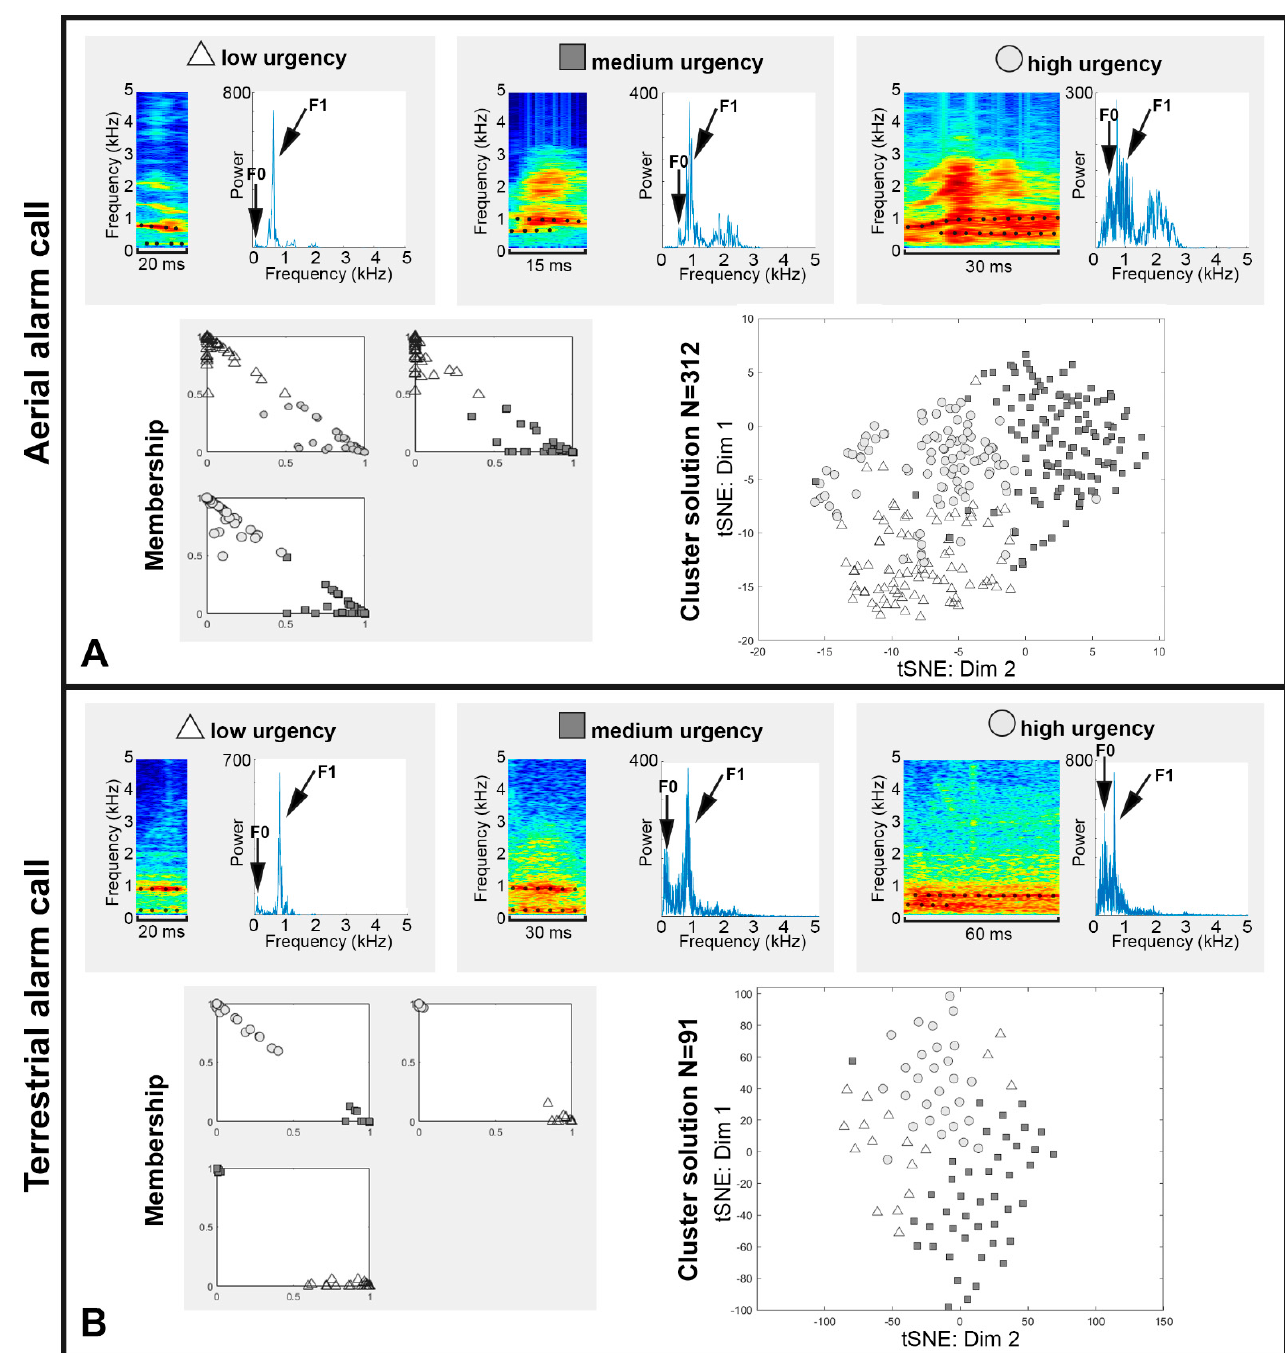
Figure 4. Fuzzy clustering results for both alarm call types (( A ) = aerial alarm calls; ( B ) = terrestrial alarm calls), with one example per urgency level (triangle, square, and circle). For each urgency level, the features duration, F0 and F1, are indicated. Each vocalization is shown as both a spectrogram (left) and a spectrum (right). In both, the noise component within the vocalizations is well discernible via the broad, non-specific distribution of the high-energy frequencies. The diagram “Membership” provides a pairwise comparison of cluster segregation. Each call is assigned a membership value between 0 and 1 for the associated cluster, where 1 corresponds to a 100% membership. Each diagram compares two urgency clusters (triangles, squares, and circles indicate which urgency cluster the individual data points belong to). In this way, the membership values (x- and y-axes) can be used to determine the affiliation of the individual calls to the respective urgency cluster and to estimate the degree of convergence between the urgency clusters.